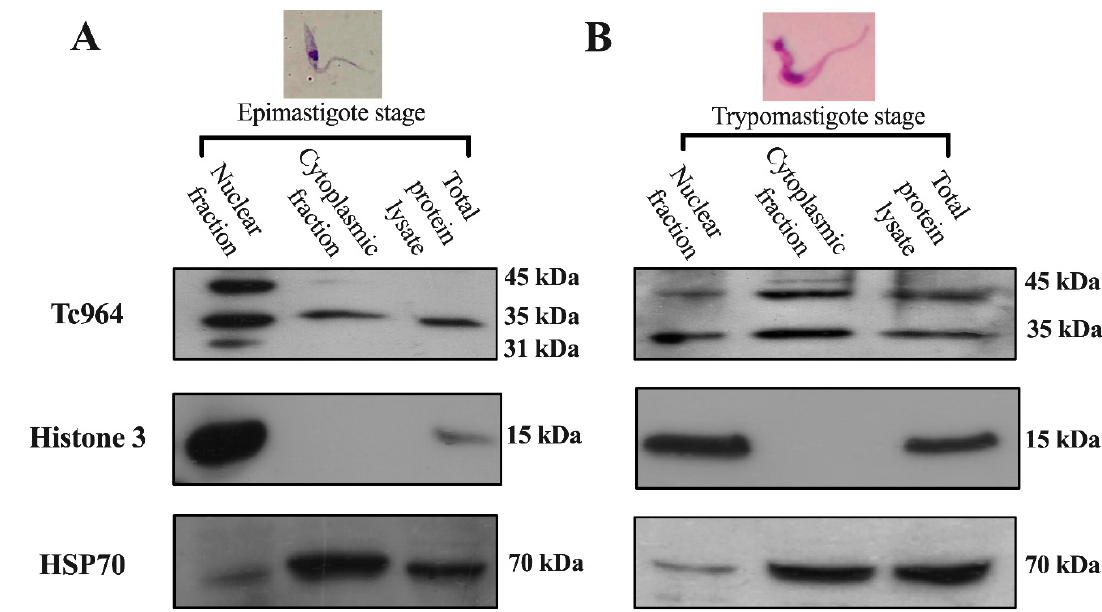
Figure 3. Subcellular localization of the Tc964 protein. ( A ) Detection of the Tc964 protein (35-kDa) in epimastigotes from the Y strain (DTU II) using an anti-Tc964 as primary antibody. ( B ) Tc964 detection on trypomastigotes strain Y (DTU II), with the anti-Tc964 antibody. Antibodies against Histone 3 (nuclei) and Heat-Shock Protein 70 (cytoplasm) were used as controls of subcellular fractionation.